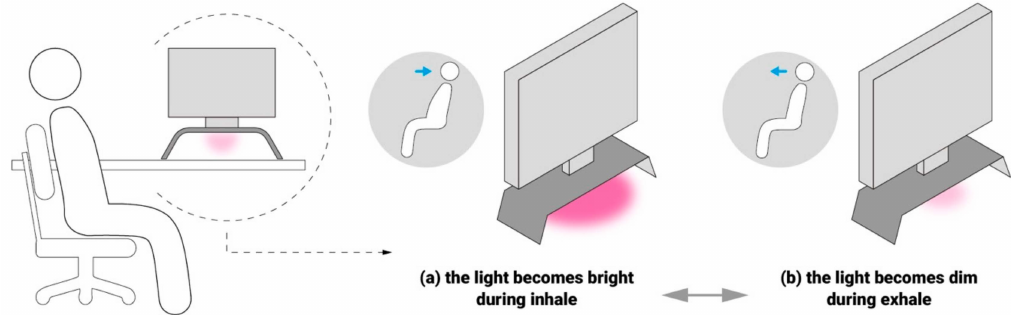
Figure 8. The working mechanism of LightSit to facilitate deep breathing relaxation. ( a ) The light becomes bright during inhale. ( b ) The light becomes dim during